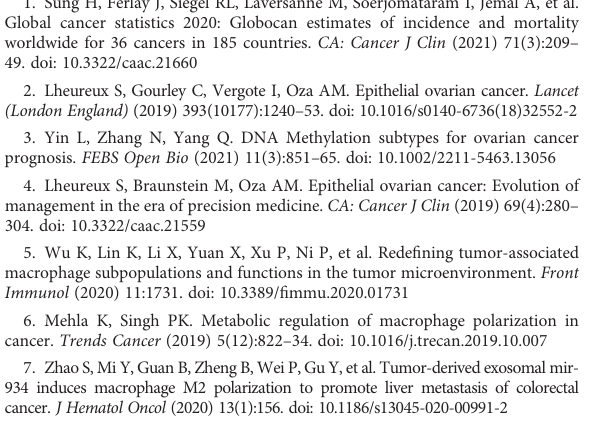
SUPPLEMENTARY FIGURE 3 GO and KEGG analysis based on the GSEA algorithm. (A) GO analysis based on the GSEA algorithm; (B) KEGG analysis based on the GSEA